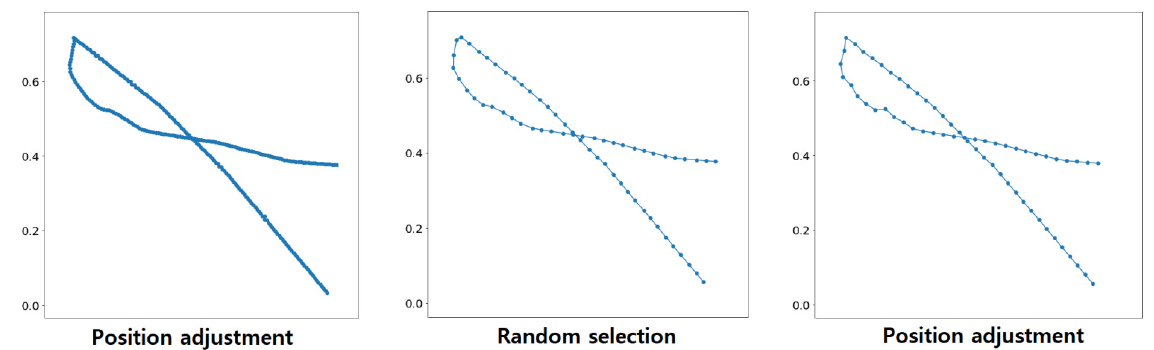
Figure 5. Magnified view for detail.